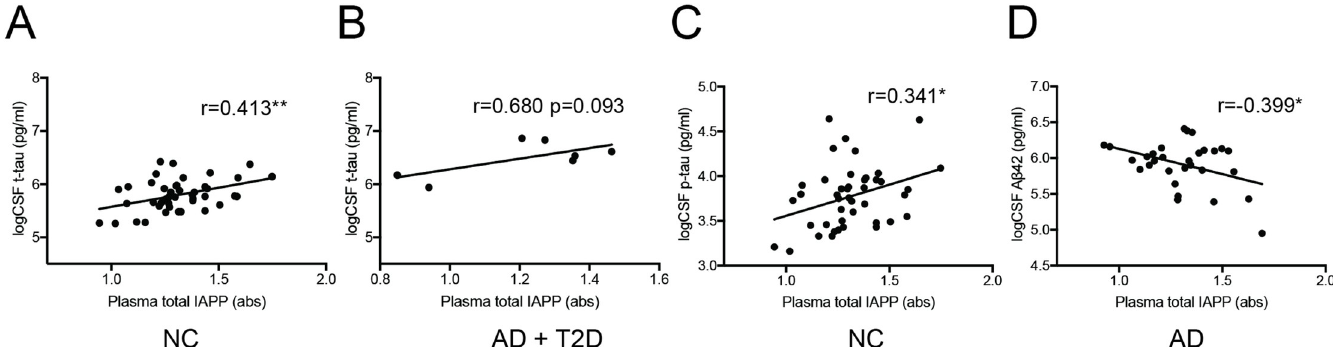
Fig 3. Correlations between total plasma IAPP and AD biomarkers. Scatter plots demonstrate correlation between levels of total plasma IAPP and logarithmic transformed values of CSF t-tau in NCs (A) and a trend towards a correlation in patients with AD+T2D (B). Scatters plots also demonstrate a positive correlation between levels of total plasma IAPP and logarithmic transformed values of CSF p-tau in NCs (C) as well as a negative correlation between levels of total plasma IAPP and logarithmic transformed values of CSF A β 42 in AD patients (D). Data was analyzed using Pearson correlation test. � Significant correlation at p < 0.05.